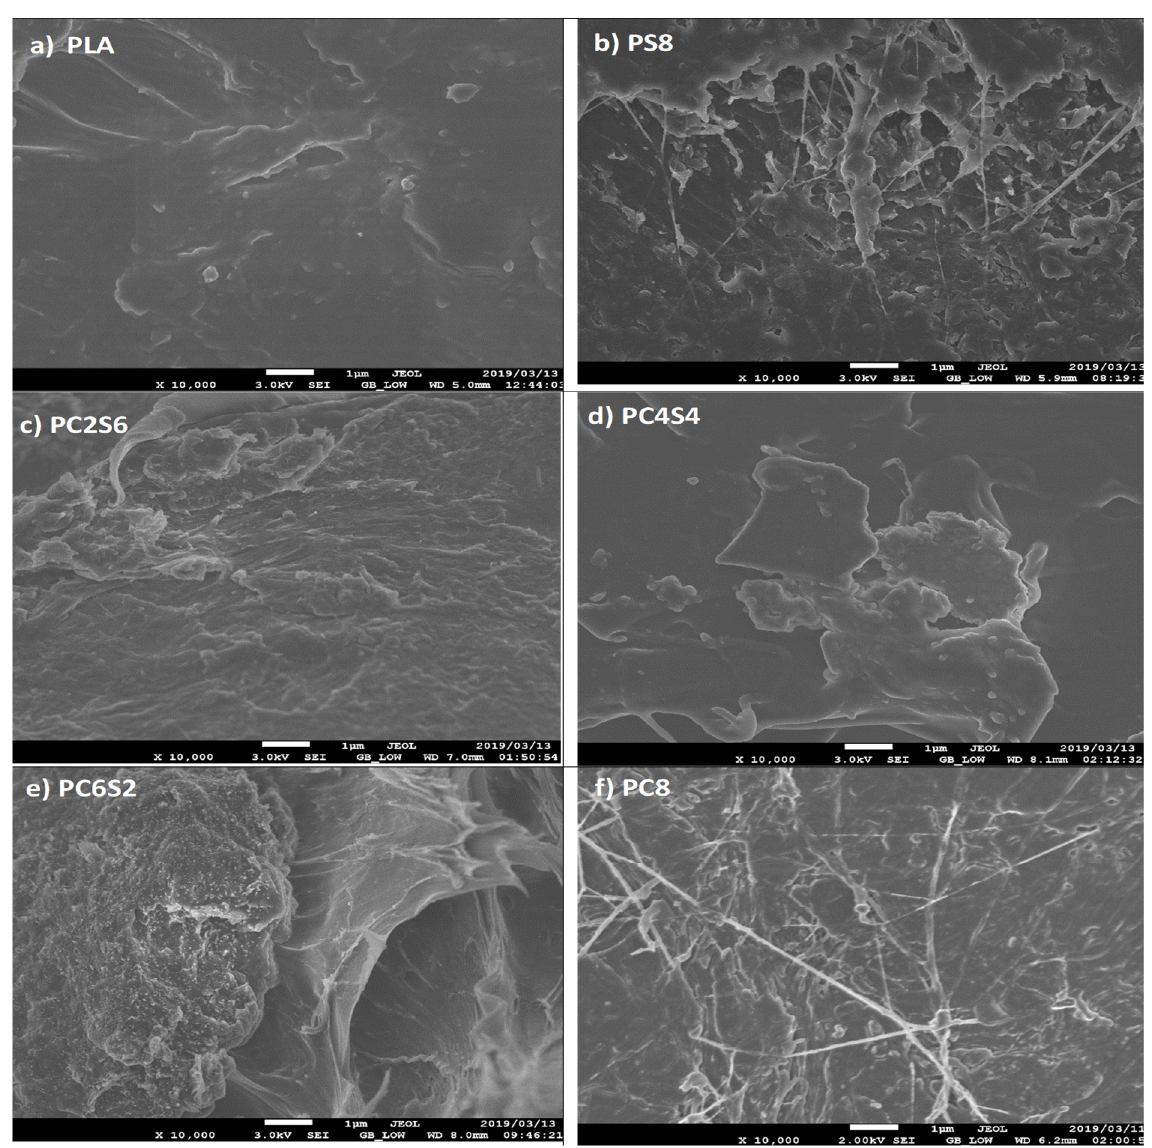
Figure 11. High magnification micrograph of the tensile fractured surface of the biocomposite. The percentage weight loss for the neat PLA and the biocomposites are shown in Figure 12a. Figure